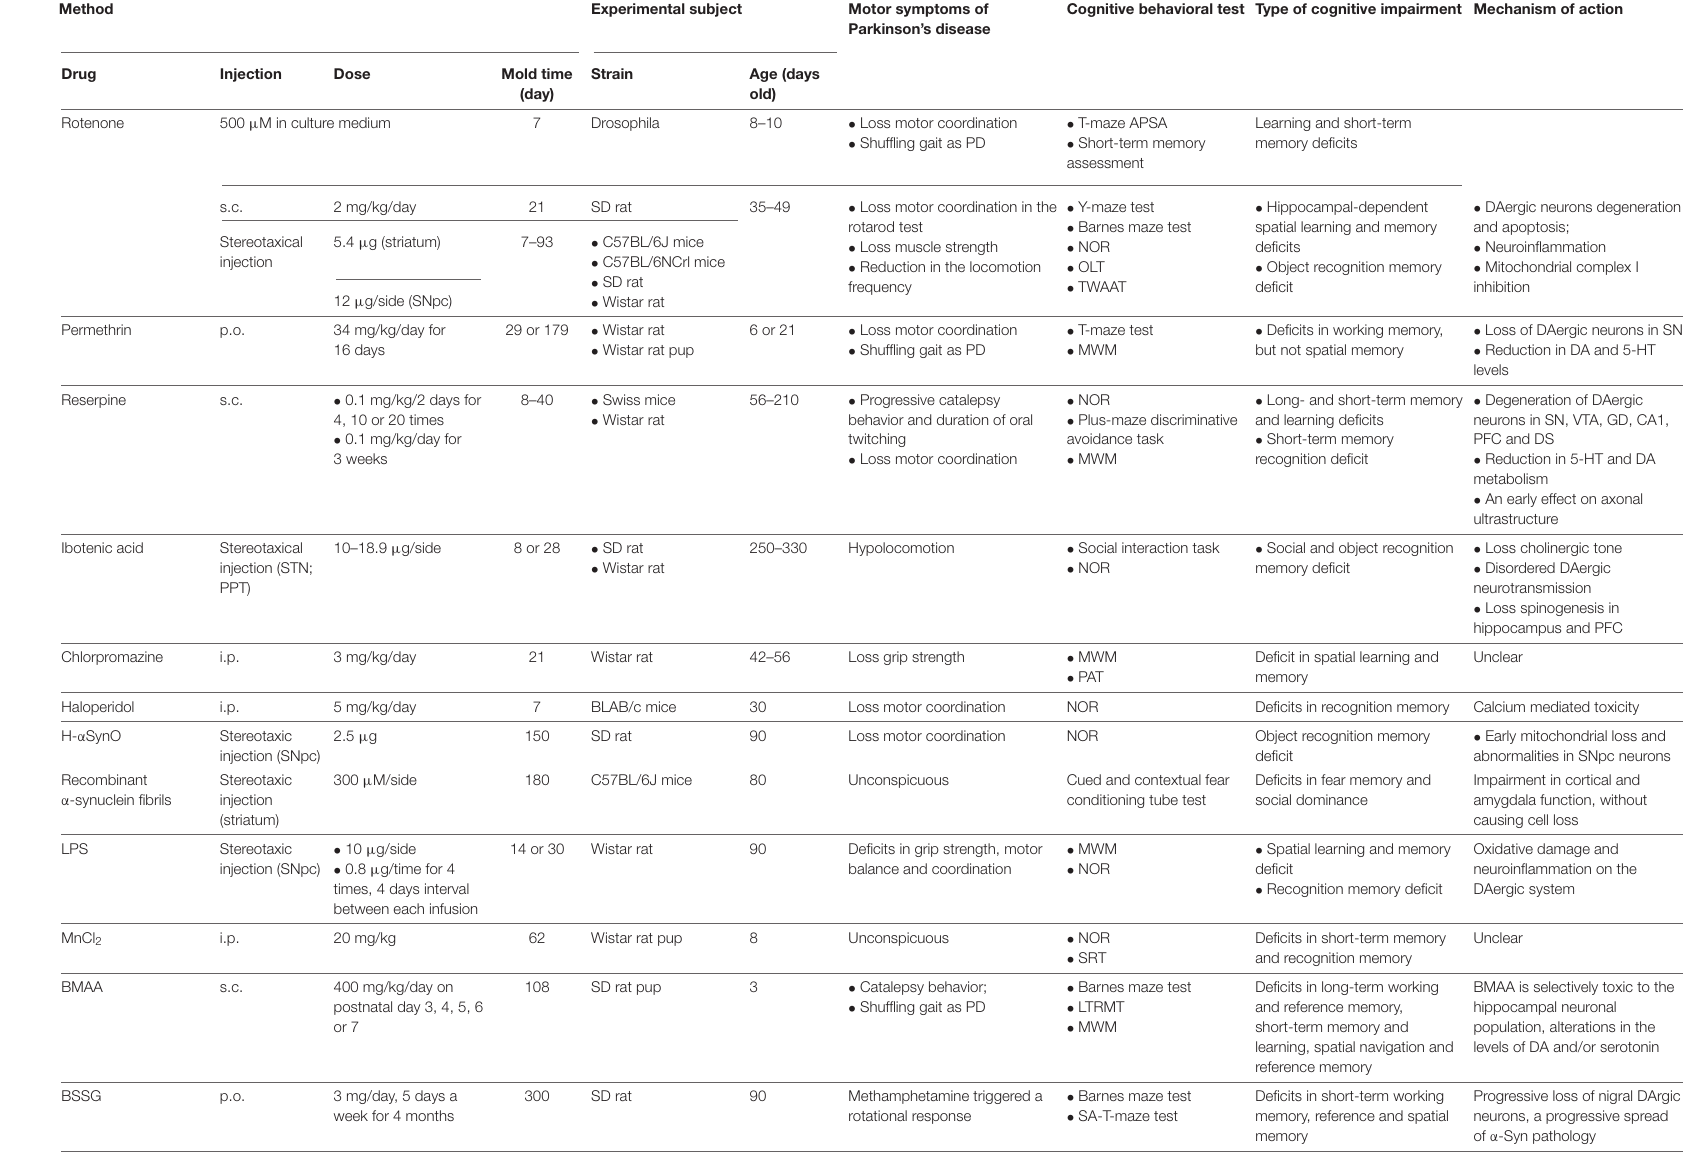
TABLE 4 | Methods of novel toxin-induced experimental